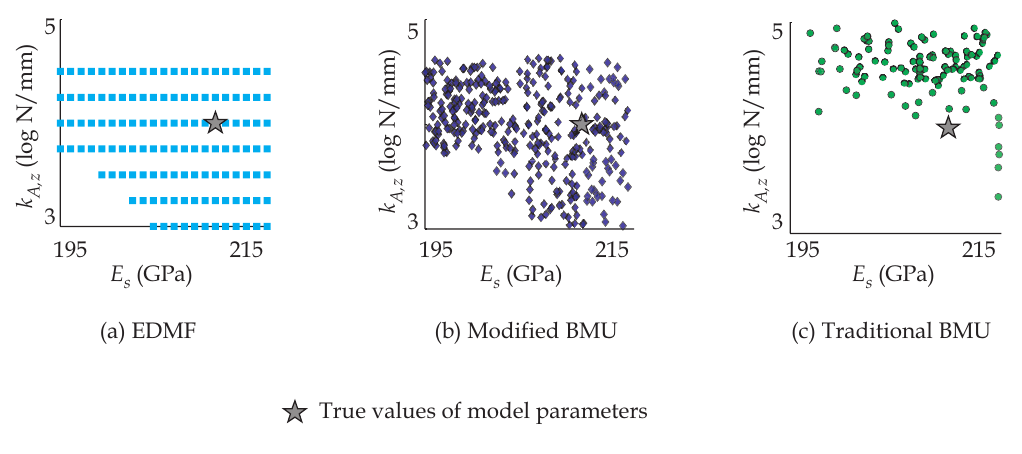
Figure 5. Samples from updated parameter distributions obtained using: ( a ) EDMF; ( b ) modified BMU; and ( c ) traditional BMU before retrofit of the Ponneri